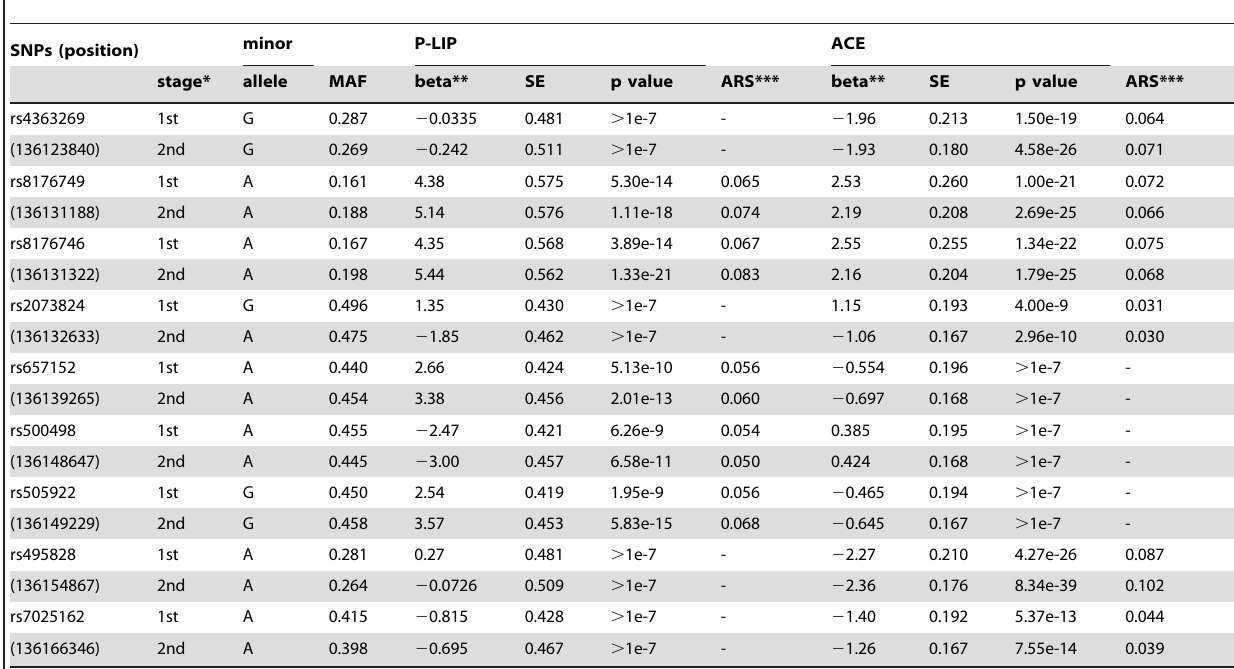
Table 1. Associations of ABO gene in 9q32 with P-LIP and ACE in Takahata and Yamagata populations.